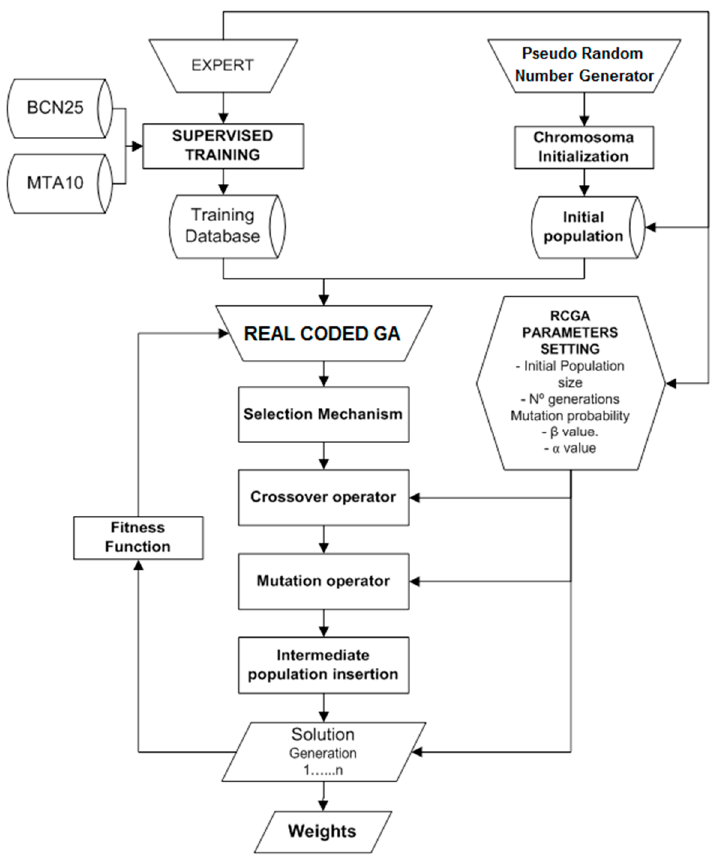
Figure 4. Conceptual framework for the classification process. RCGA, Real Coded GA.